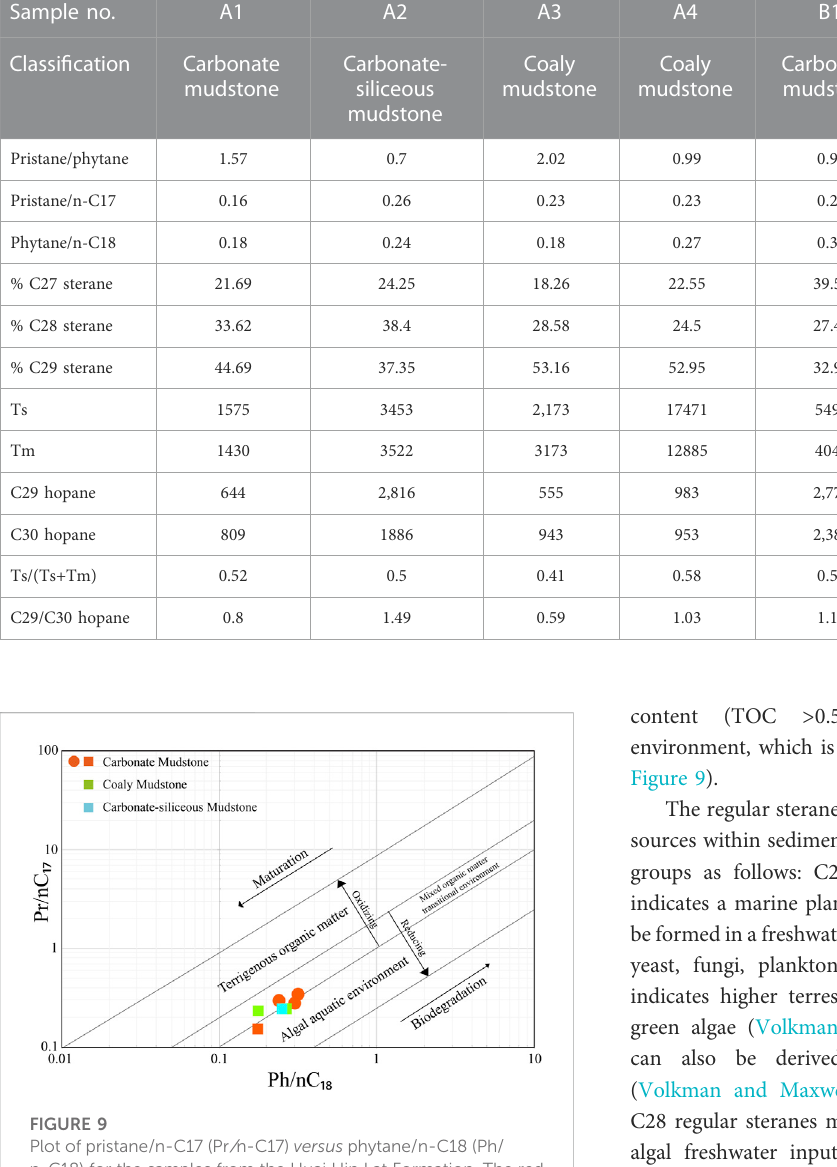
TABLE 4 The geochemical results and biomarker ratios of saturated hydrocarbon of the samples from the Huai Hin Lat Formation. Sample no.